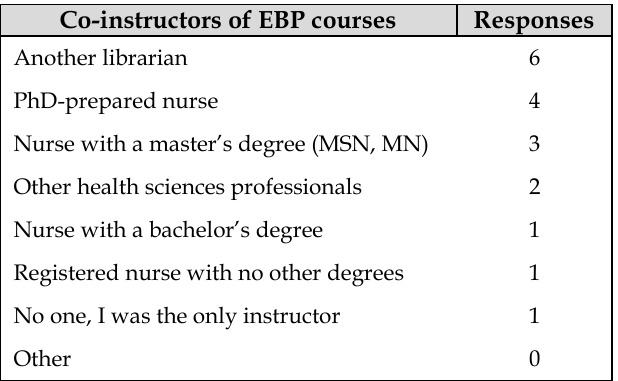
Table 4 Partnerships with other professionals to teach